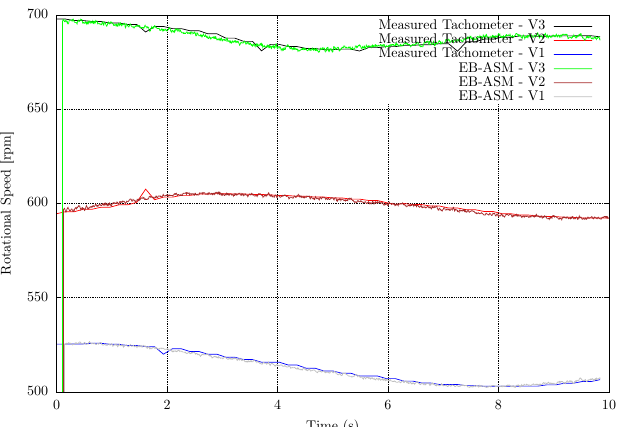
Figure 7. Event-based Angular Speed Measurements applied for a rotating fan at three different speed stages, named V1, V2 and V3.